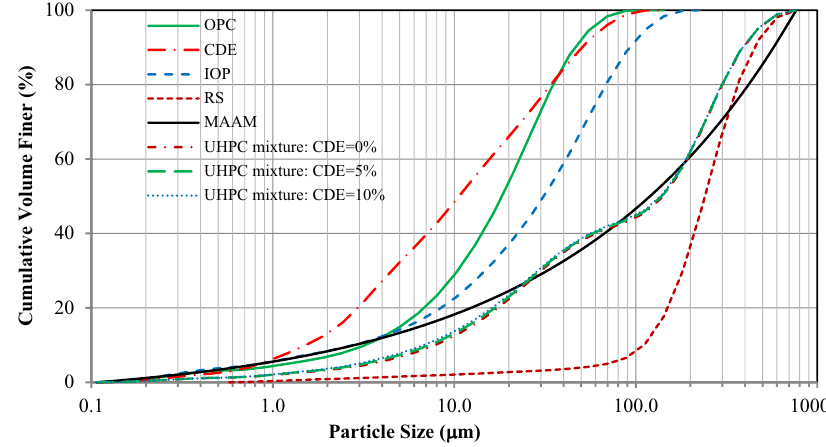
Figure 1: Particle size distribution of materials, target curve ( MAAM ) , and grading curve of UHPC